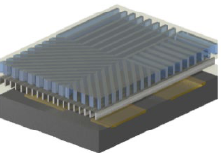
Fig. 2. Schematic of an integrated Stokes polarimeter consisting of a (top to bottom) birefringent grating as QWP, wire grid polarizer as LP and an image